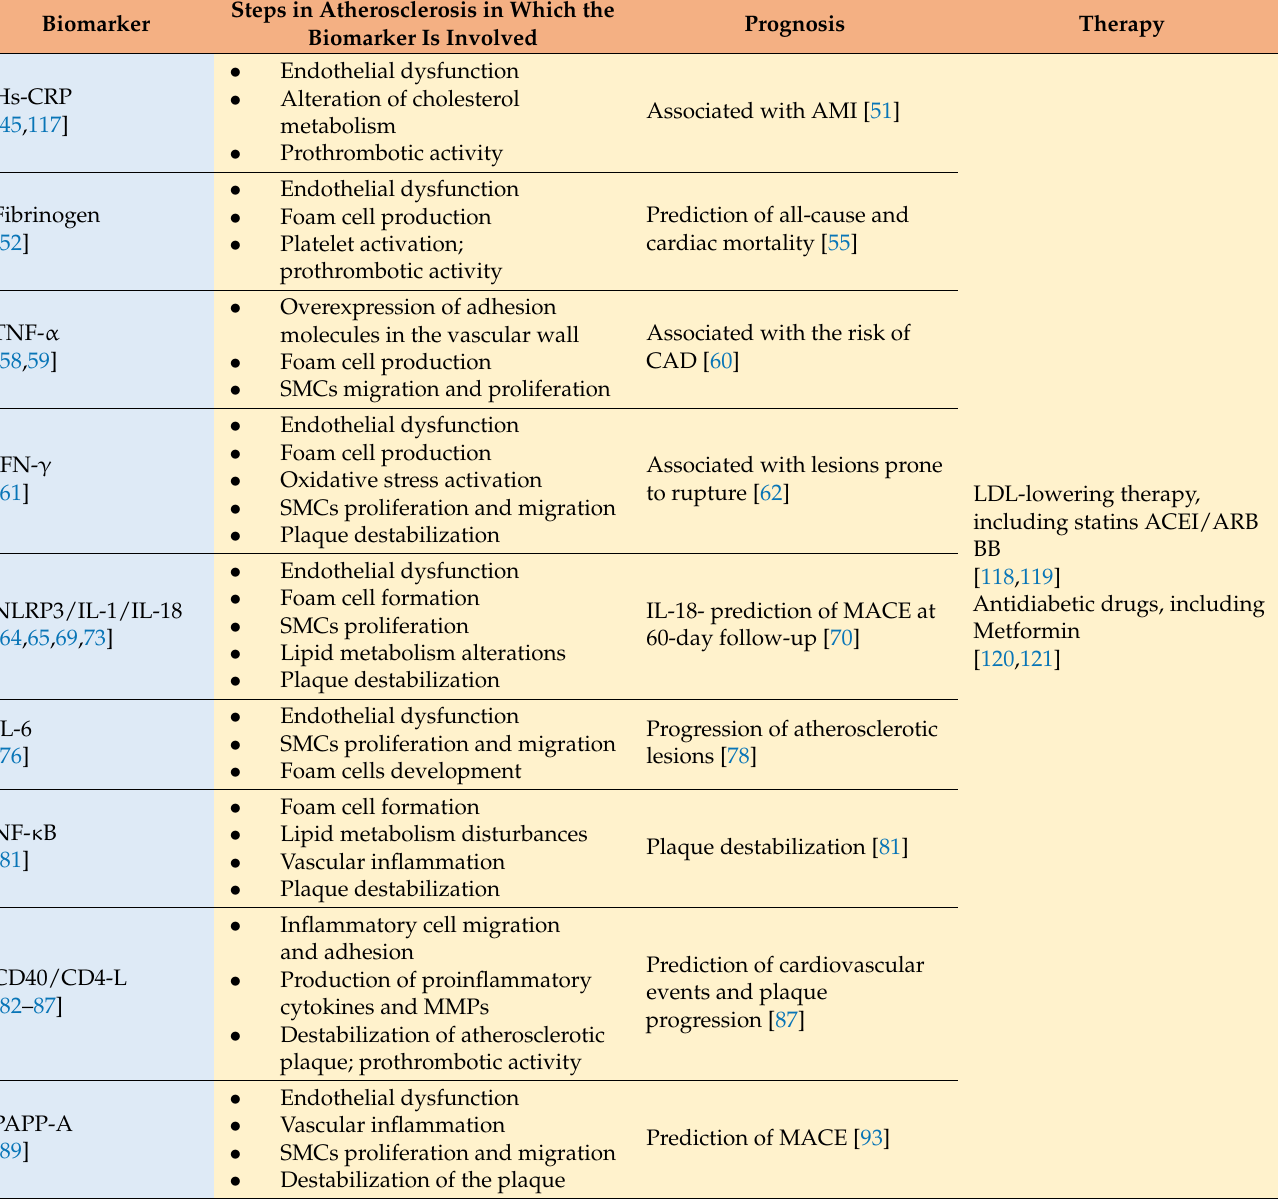
Table 2. The main biomarkers involved in atherosclerosis developments and the most common therapeutic